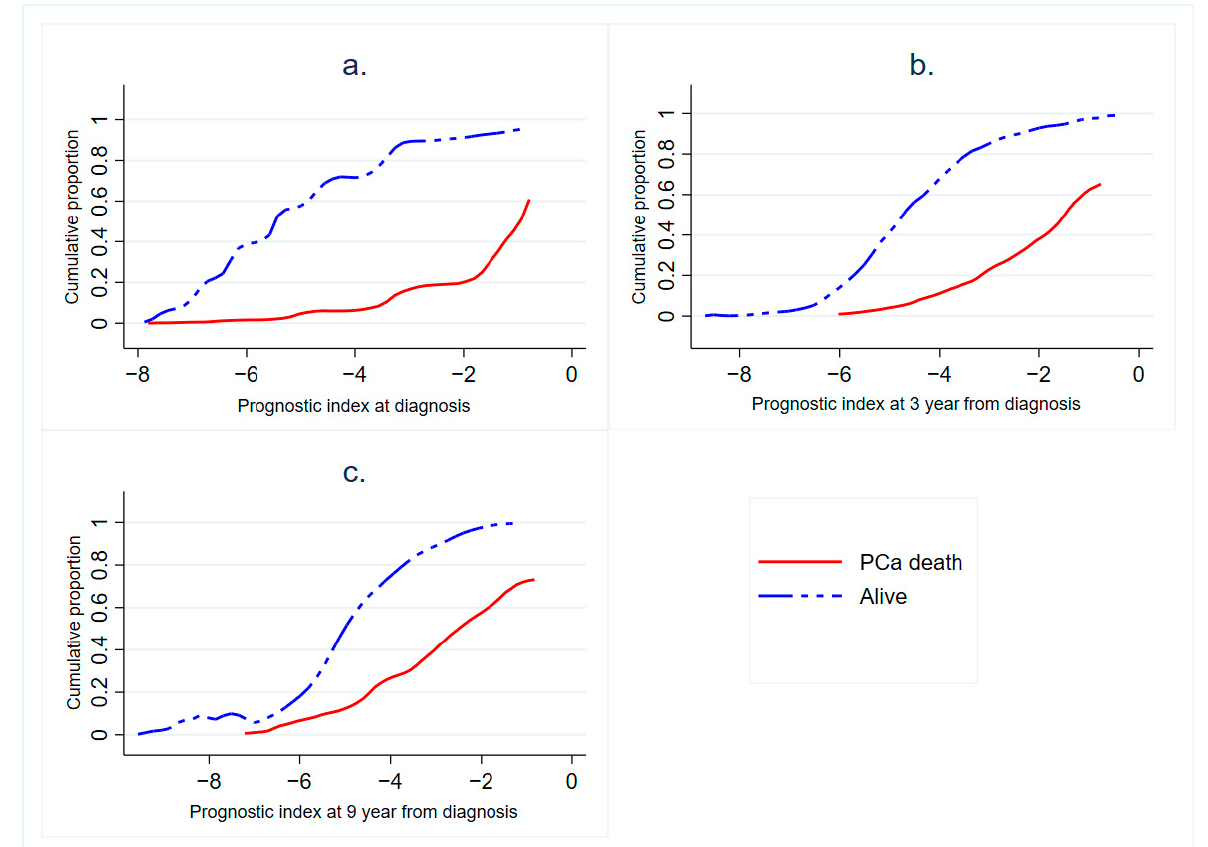
Figure 1. Cumulative distribution of prognostic index (PI) values for men who died due to prostate cancer (PCa) and those who did not during ( a ) the development period of 0–3 year ( b ) the development period of 3–9 years and ( c ) the development period of 9–20 years. The distribution of men is described as a cumulative frequency across values of the PI from low (indicating worse survival) to high (indicating favorable survival).